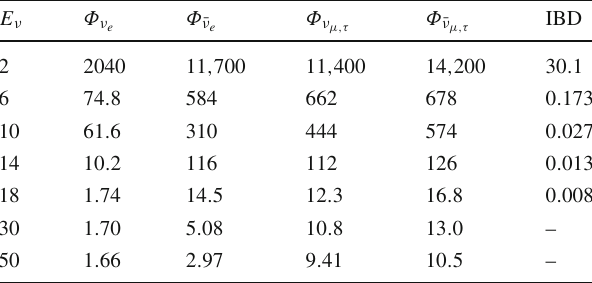
Table 2 Borexino 90% C.L. upper limits for the total FRB fluences of all neutrino flavours, obtained through the study of (ν, e ) elastic scat- tering of monoenergetic neutrinos (2058 d) and IBD reaction (2485 d). E ν is given in MeV units, Φ ν – in 10 12 cm − 2 units x , ¯ ν x